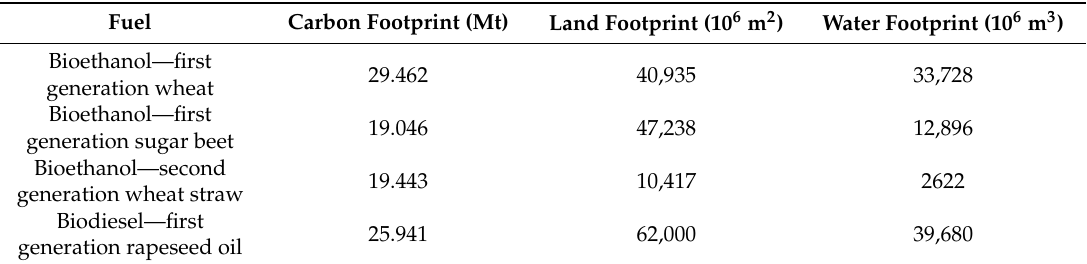
Table A8 shows the carbon, land and water footprints for scenario 4, the biofuels scenario. Table A8. Carbon, land and water footprints for scenario 4, the biofuels